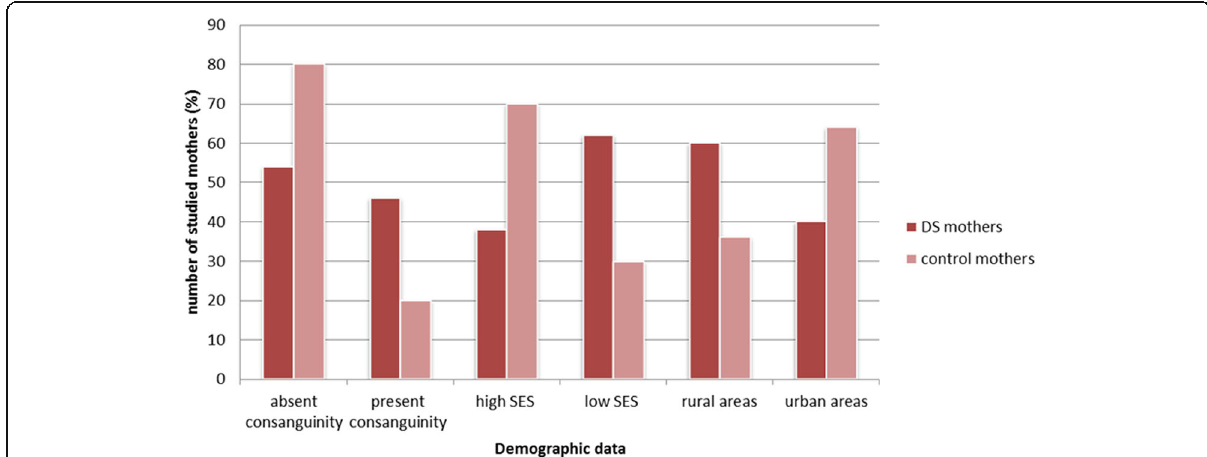
Fig. 1 The distribution of consanguinity, socioeconomic status (SES), and residency among young mothers of DS children in comparison to control mothers